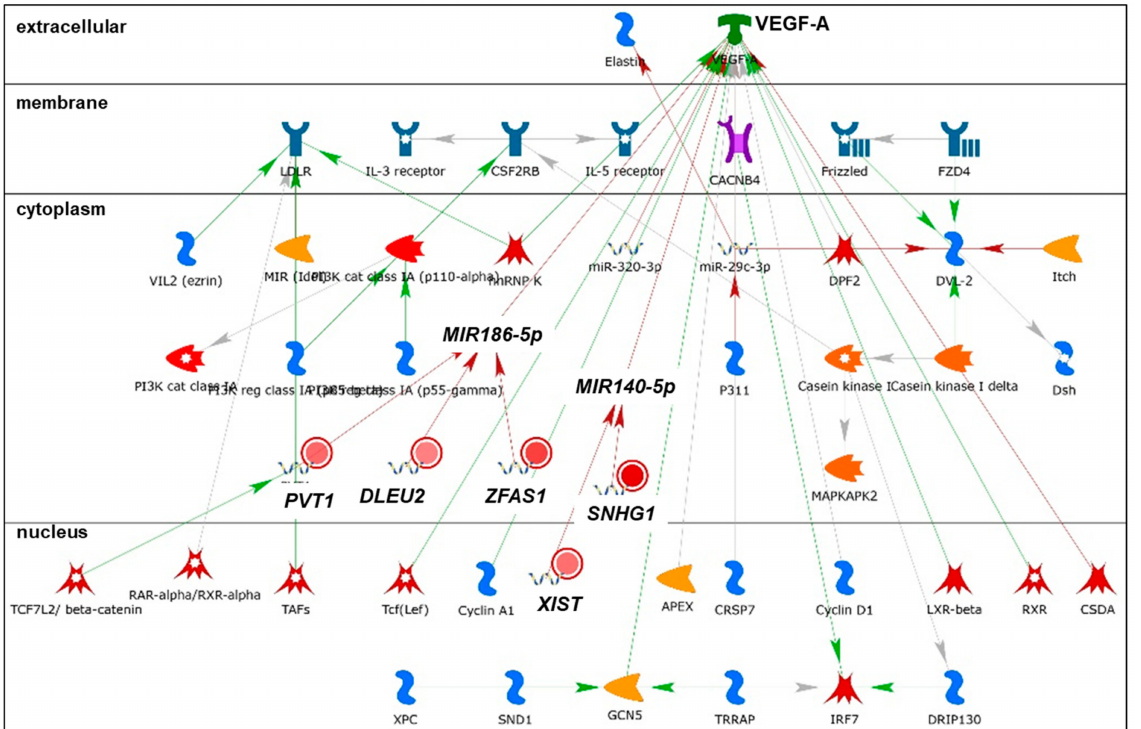
Figure 10. Network 2: PVT1, ZFAS1 RNA, XIST, SNHG1, and DLEU , identified in lncRNAs differentially expressed in MCF-7 and or LCC9 cells by MetaCore analysis. Green lines with arrows = stimulation; red lines with arrows =